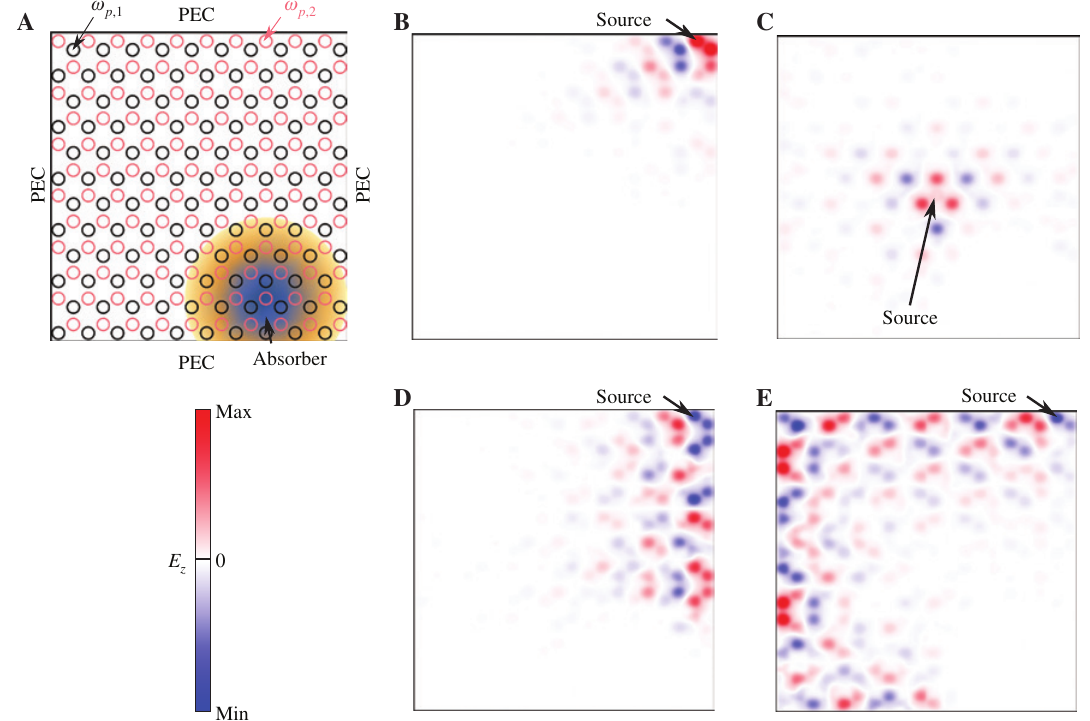
Figure 3: Edge states of a photonic graphene cavity. (A) Schematic of the cavity: the photonic crystal of Figure 1B with an absorber located at the right-bottom region and surrounded by PEC walls. The pseudo-Tellegen response ξ is not represented in the figure. (B) Time snapshot ( t = 0) of E for the material with a broken IS of z ≈ 0.677 in Figure 2B. (C)–(E) Time snapshot ( t = 0) of E for the material with a broken TRS of Figure 2C. The pseudo-Tellegen parameter is ξ z 0 ≈ −0.677 in (C) and (D) and ξ 0 Figure 3B–E. As seen in Figure 3B, the phase character- ized by a broken IS does not support any bulk or unidirec- tional edge mode at this frequency, confirming that this phase is topologically trivial. The absence of bulk modes for the phase with a broken TRS is also verified in Figure 3C, which reveals that for an excitation far from the edges, the fields decay rapidly with the distance to the source. The situation is dramatically different for sources positioned near the boundaries. Figures 3D and E show 4.33 –0.4 –0.3 –0.2 –0.1 0 that in such a case a unidirectional edge state with propa- gation direction locked to the sign of ξ is excited near the 0 PEC walls. Crucially, the topologically protected modes Figure 4: Dispersion diagram of the bulk and edge modes (top do not experience any backscattering at the corners of interface) as a function of the normalized wavevector. the cavity. The edge mode dispersion in the band gap The structure parameters are as in Figure 2C. The slight asymmetry of the bulk bands with respect to q = 0 and the frequency shift with region was found by numerically fitting the spatial varia- respect to Figure 2C are numerical artifacts caused by a relatively tion of the edge waves to that of a Bloch wave. As depicted coarse mesh in the simulations of the electrically large topological in Figure 4, the edge mode dispersion is approximately cavity of Figure 3. linear, and for the edge wave propagating attached to the top interface it is centered about the K point and spans the entire band gap. The gap Chern number – given by the for the phase with a dominant broken TRS. In agree- sum of the Chern numbers of the bands below the gap, ment with the results of [48, 49], the gap Chern number = sgn( ξ including the negative frequency bands – is C is positive (negative) for an energy flow in the clockwise ) gap 0